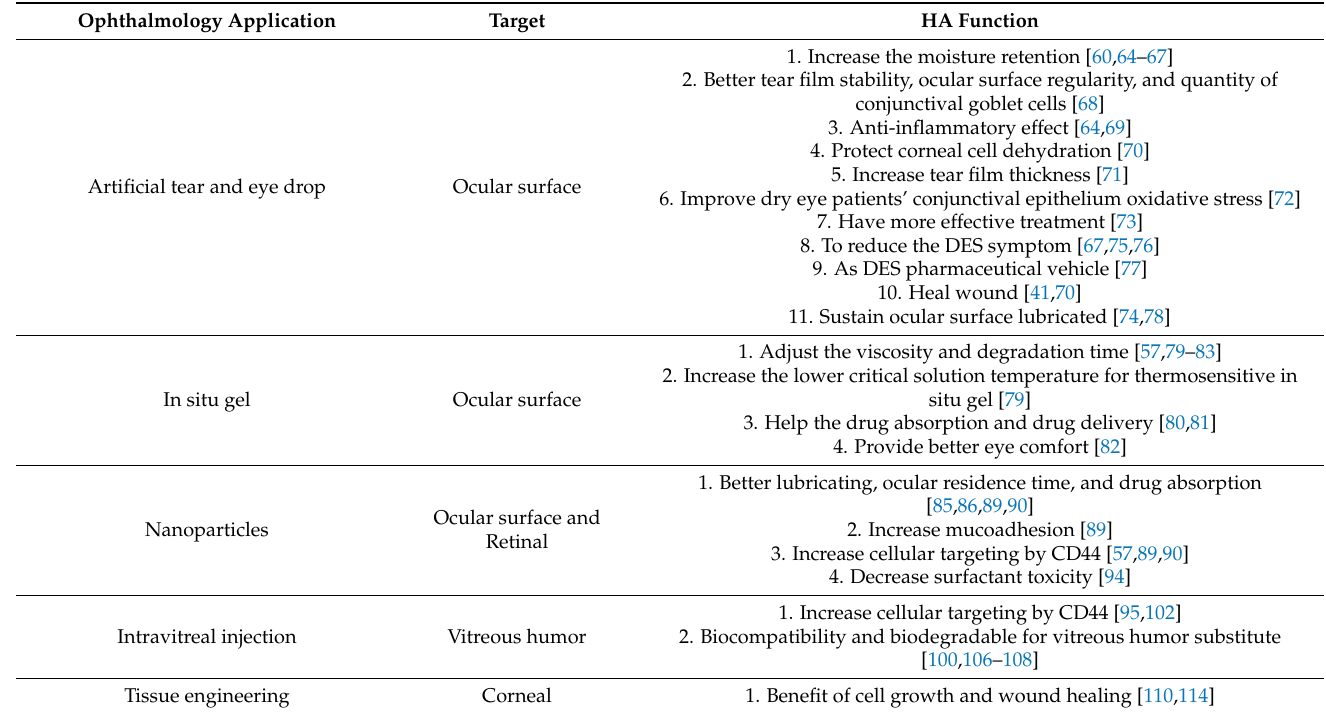
Table 2. Applications of HA in